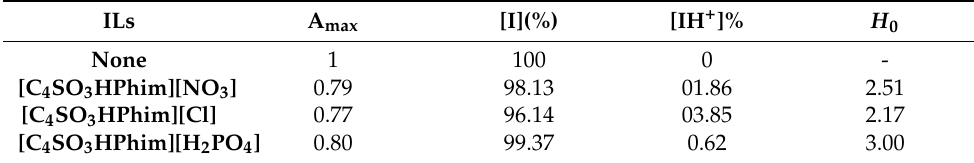
Table 1. The values of Hammett acidity function ( H 0 ) for all Brønsted acidic IL catalysts. ILs